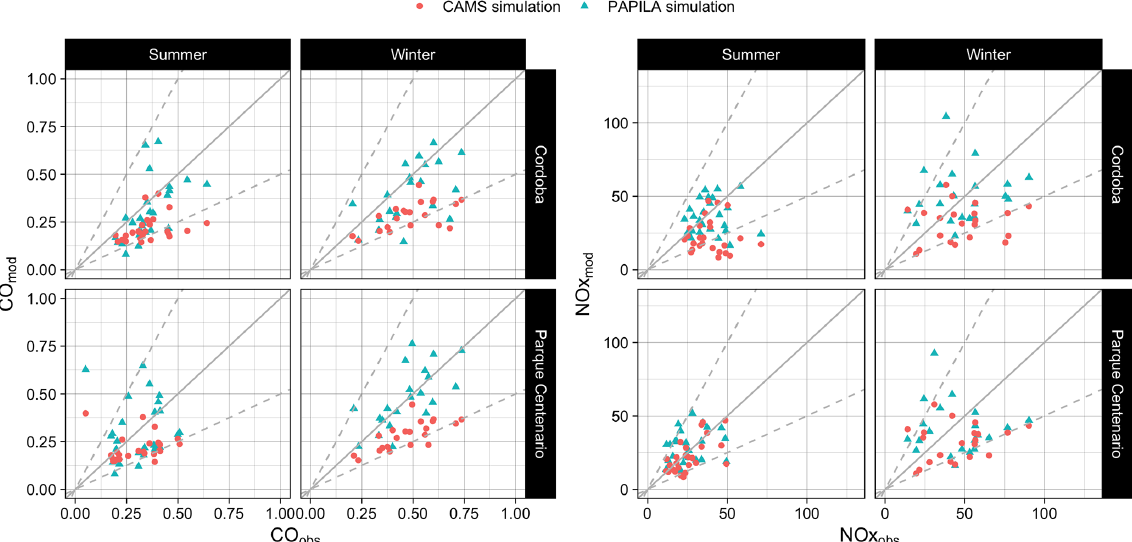
Figure 6. Scatter plots for observed and modeled daily concentrations for both sites. Values within the dotted lines represent the fraction of values that are within a factor of 2 of the observations (FAC2). CO concentrations are in parts per million and NO x in parts per